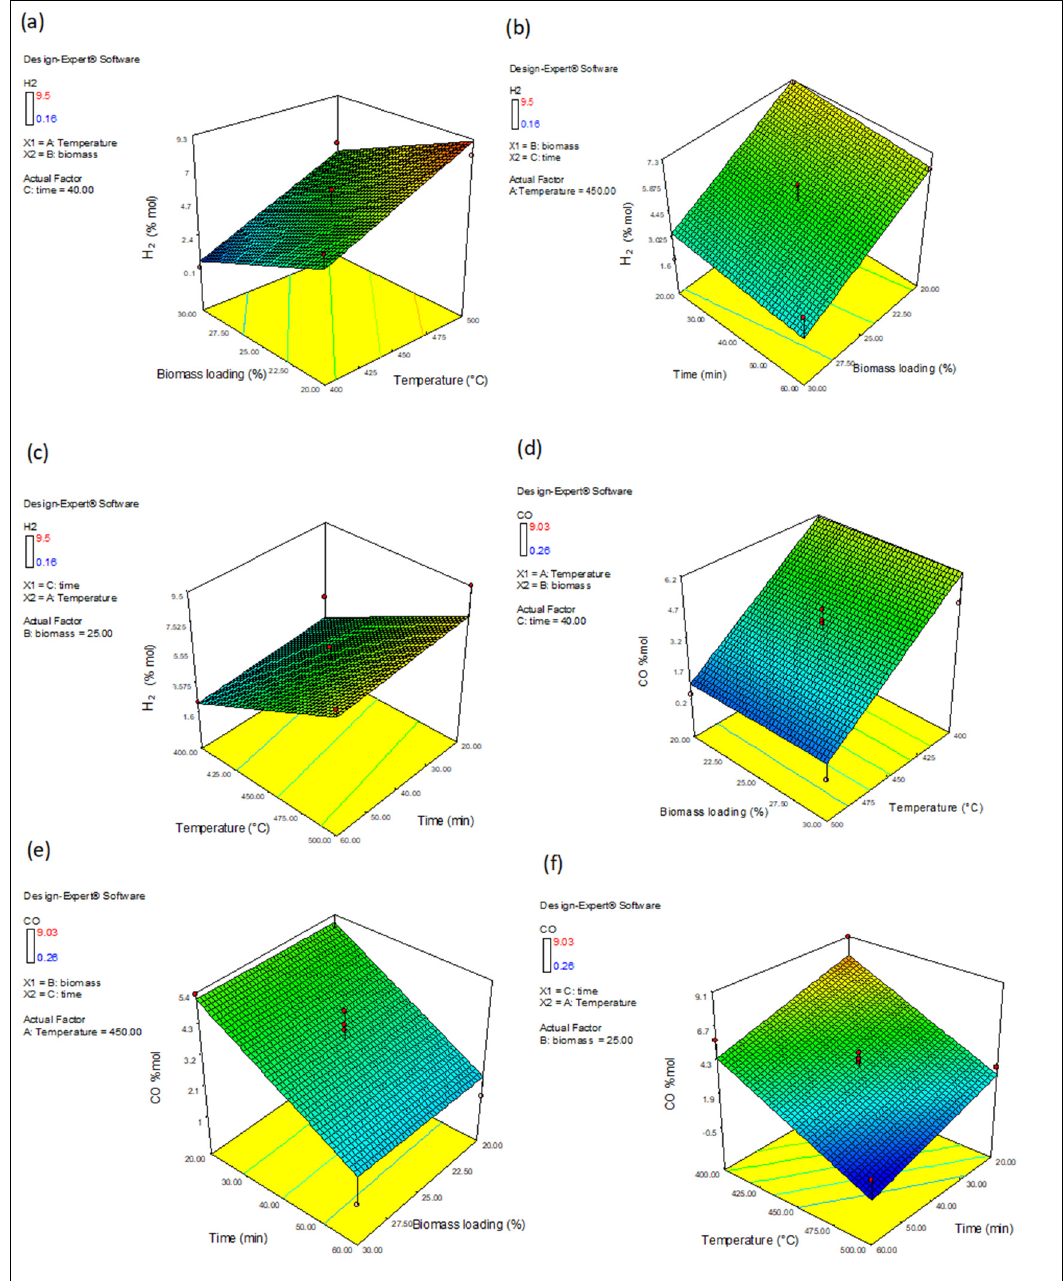
Figure 10. Three-dimensional response surface plots of interaction e ff ects of variables on gas com- position: H 2 ( a – c ) and CO ( d – f ) yields. sition: H 2 ( a – c ) and CO ( d – f )